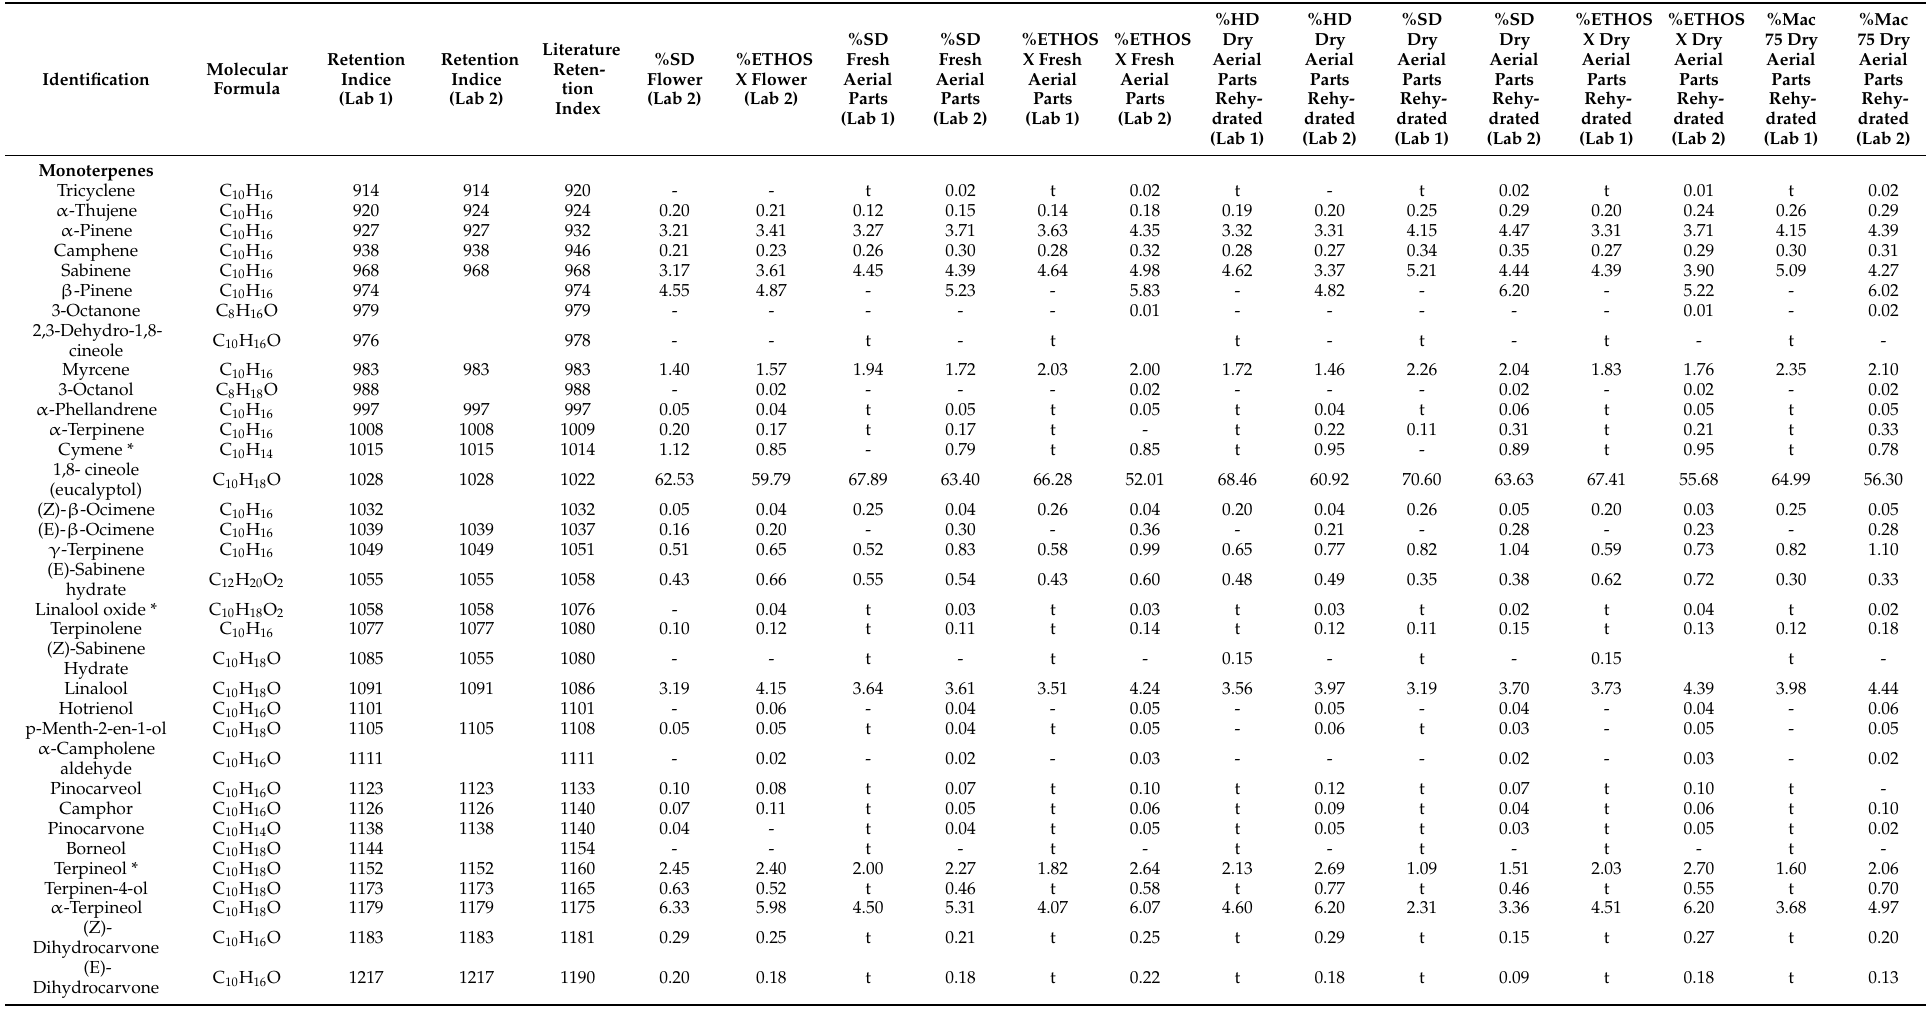
Table 1. Chemical compositions of Thymus mastichina essential oils obtained from steam distillation (SD), hydrodistillation (HD), or solvent-free microwave extraction (SFME) at laboratory (ETHOS X) or pilot scale (Mac 75) from flowers and fresh or dry aerial